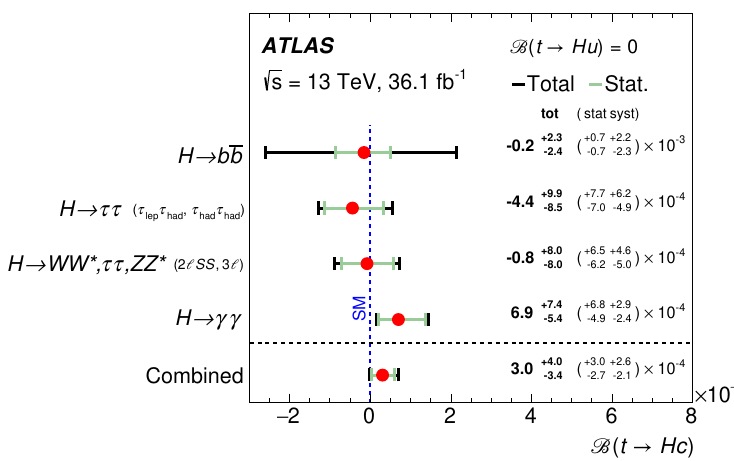
Figure 11 . Summary of the best-(cid:12)t B ( t ! Hc ) for the individual searches as well as their combination, assuming B ( t ! Hu ) = 0.